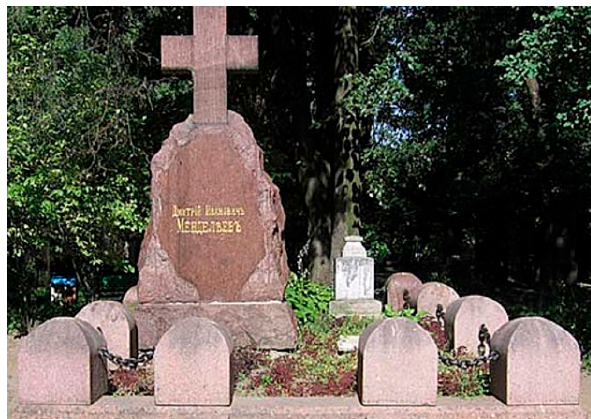
Figure 9. The tomb of Mendeleev in Volkov’s cemetery in St Peters- burg (permission of Museum and archives of Dmitri Mendeleev in St,